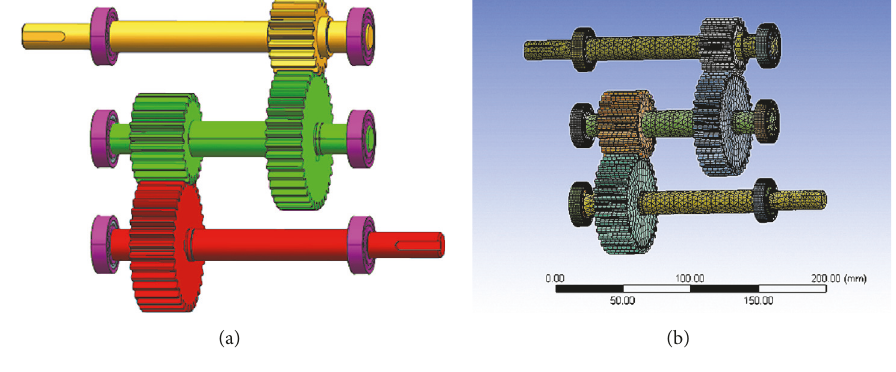
Figure 3: The meshed modal of MGTS.